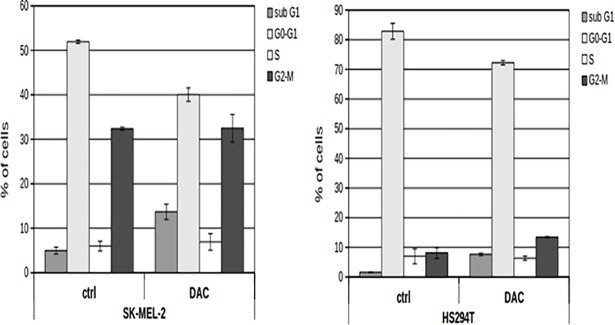
Analysis of cell cycle phases of SK-MEL-2 (left) and HS294T (right) for both untreated (ctrl) and treated (DAC) cells with 10 μM DAC for 72h. The cells % in sub-G1 (apoptotic cells), G0-G1, S and G2-M cell cycle phases are reported in Y axis. Data are reported as mean ± sd. Statistical significance threshold set at p-value < 0.05.